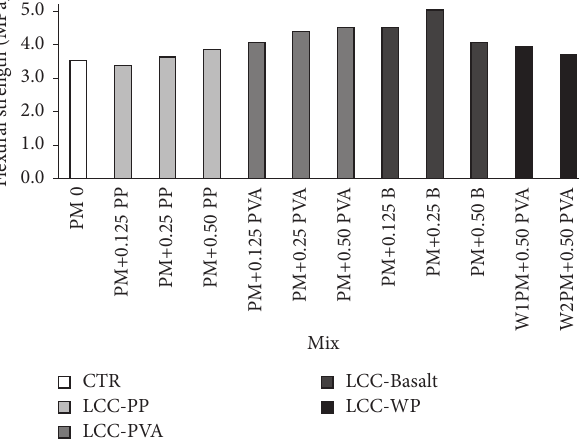
Figure 6: Flexural strength of LCC at 28days.